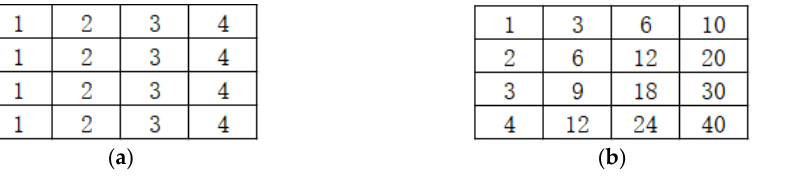
Figure 12. The gray values of image A and its integral image : ( a ) image A; ( b ) integral image .